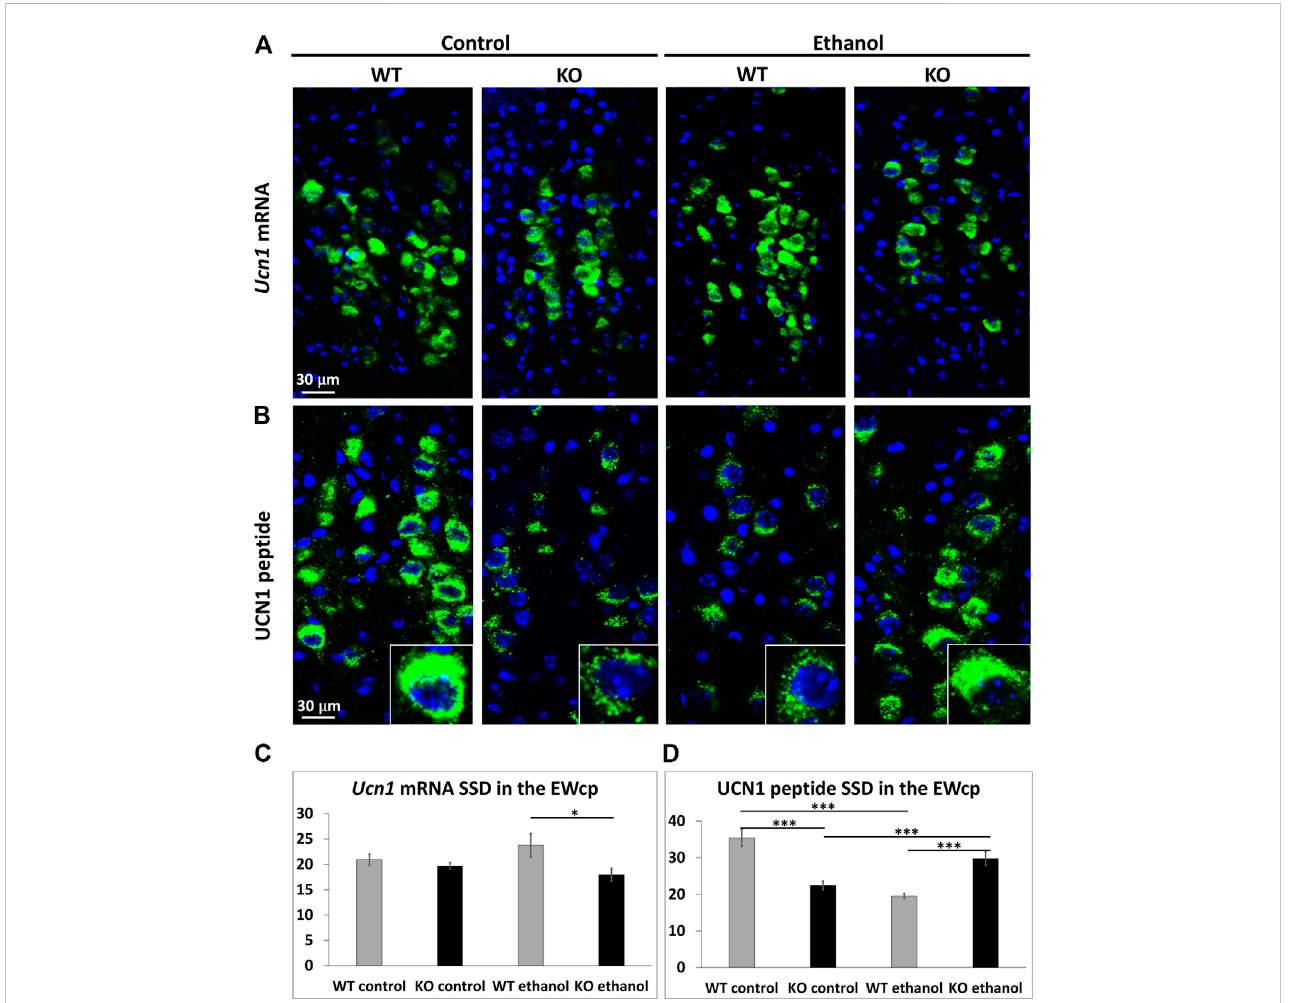
FIGURE 5 UCN1 mRNA and peptide content of the centrally projecting Edinger – Westphal nucleus (EWcp). Representative fl uorescence images showing the expressionofurocortin1( Ucn1 )mRNA(green)byRNAscope insitu hybridization (A) andtheUCN1peptide(green)byimmuno fl uorescence (B) ,intheEWcpof wildtype (WT) and Trpa1 knockout (KO) mice 2 hafter i.p., saline(control)and1 g/kgethanolinjection.Fornuclei, thesections werecounterstainedwith 4 ′ ,6- diamidino-2-phenylindole (DAPI) (blue). Quantitative evaluation of Ucn1 mRNA (C) and UCN1 peptide (D) speci fi c signal density (SSD) in the EWcp